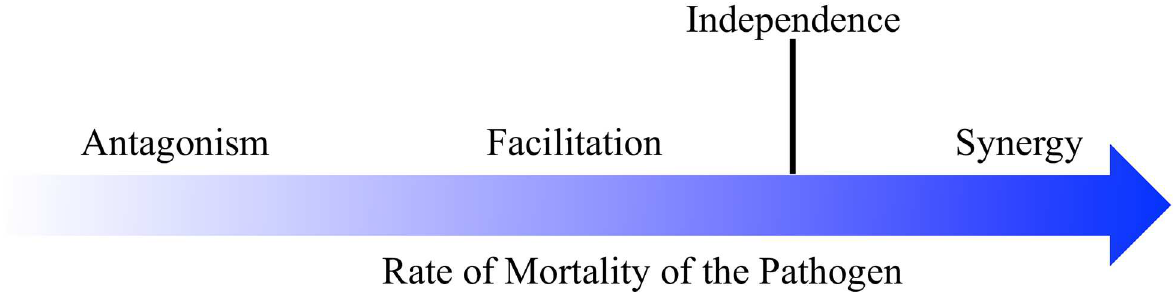
Fig 1. Possible interactions between two treatments on the rate of mortality of a target pathogen. Antagonism—in combination, the two kill the pathogen at a lower rate than the best of the treatments alone. Facilitation—together, the treatments kill at a rate greater than the best of the treatments alone but less than that if the treatments were acting independently, where they would kill at a rate equal to the product of the rates at which they act alone. Synergy—the pathogenis killedat a greater rate than that when the treatments are acting